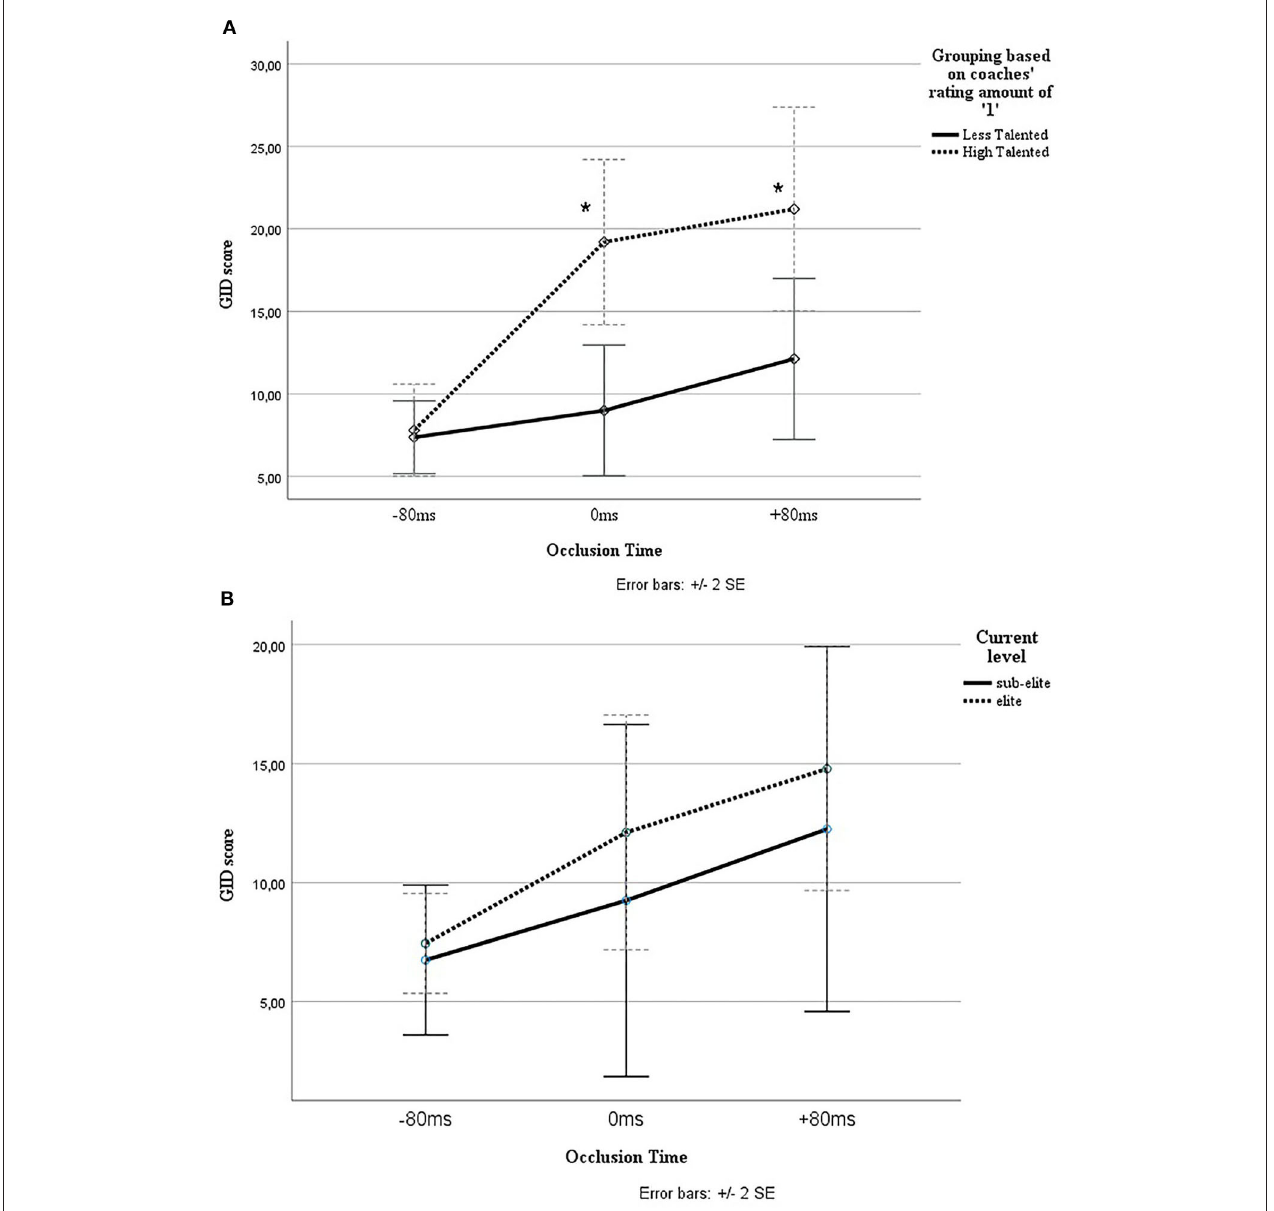
FIGURE 2 | (A) Interaction effect for the Group *Occlusion for groups based on coaches rating. *Significant ( p < 0.05). (B) Interaction effect for the Group * Occlusion for groups based on current level.